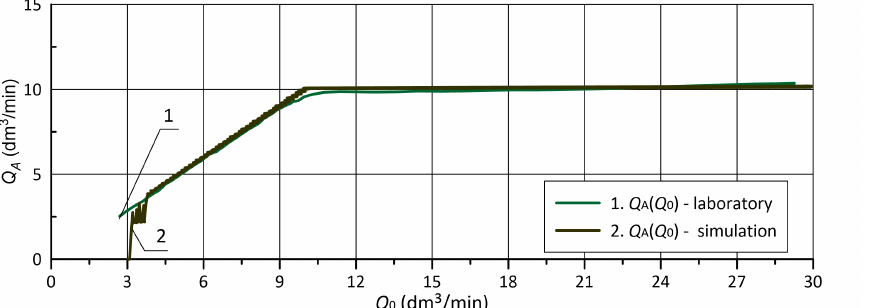
Figure 21. Controlled flow rate Q A against supply flow rate Q 0 : 1—approximated experimental curve, 2—simulation